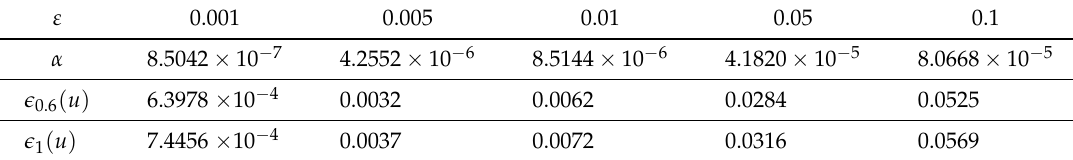
Table 2. k = 1.5, γ = 3, the relative root mean square errors for various noise levels ε at y = 0.6,1.